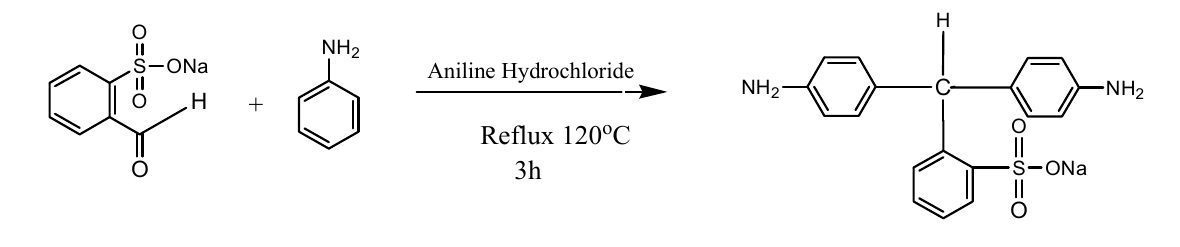
Figure 1. Synthesis of novel sulfonated diamine